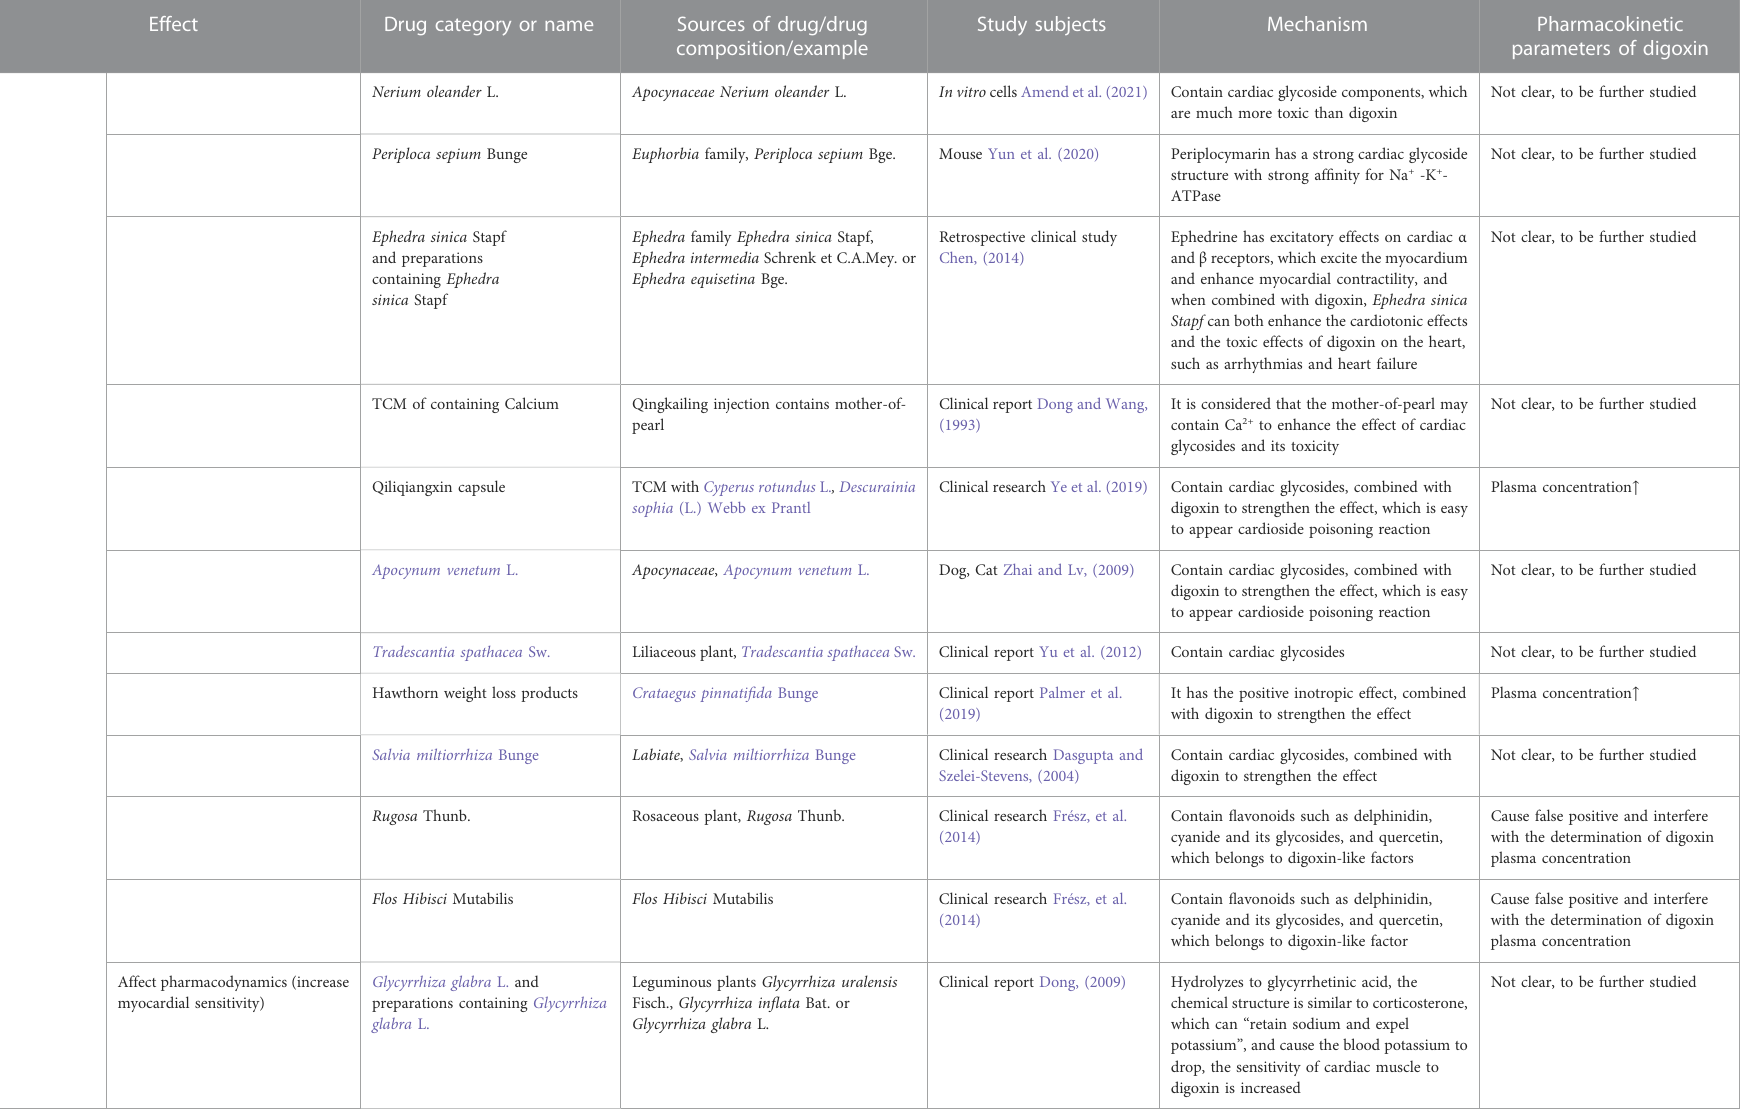
TABLE 1 ( Continued ) Interactions between TCM formulations and digoxin, and the underlying